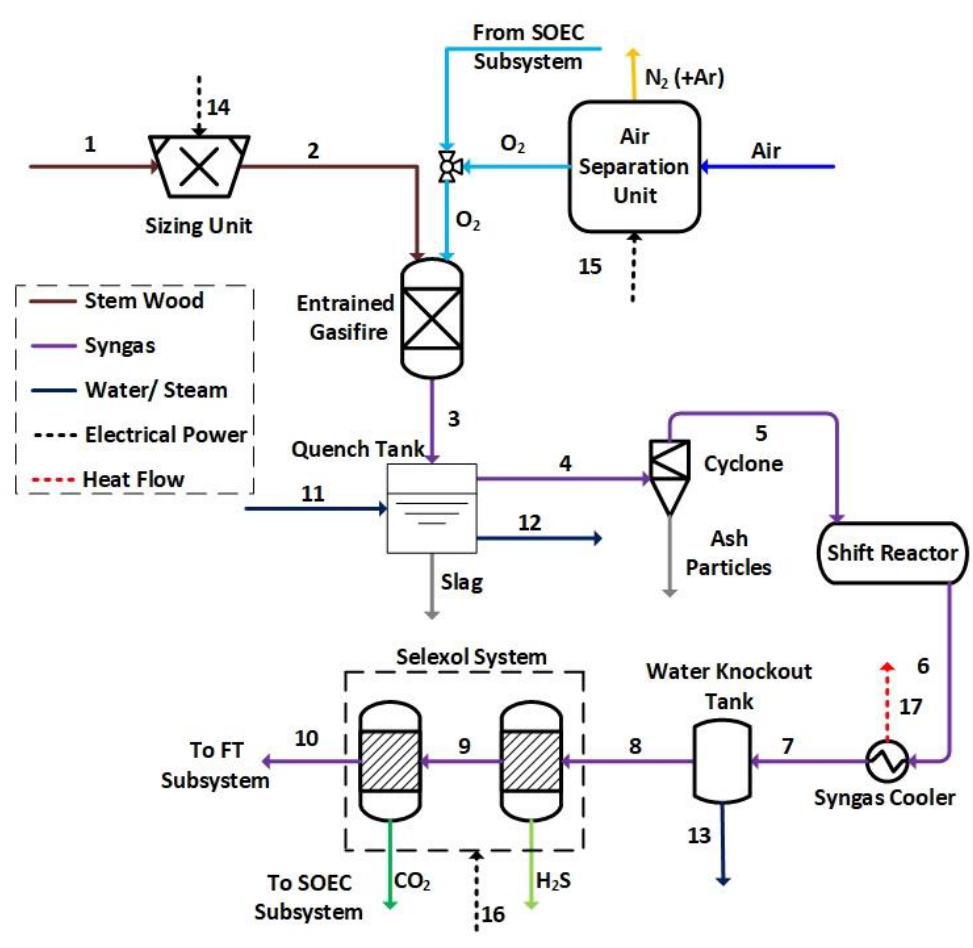
Figure 3. Schematic of the EG subsystem.